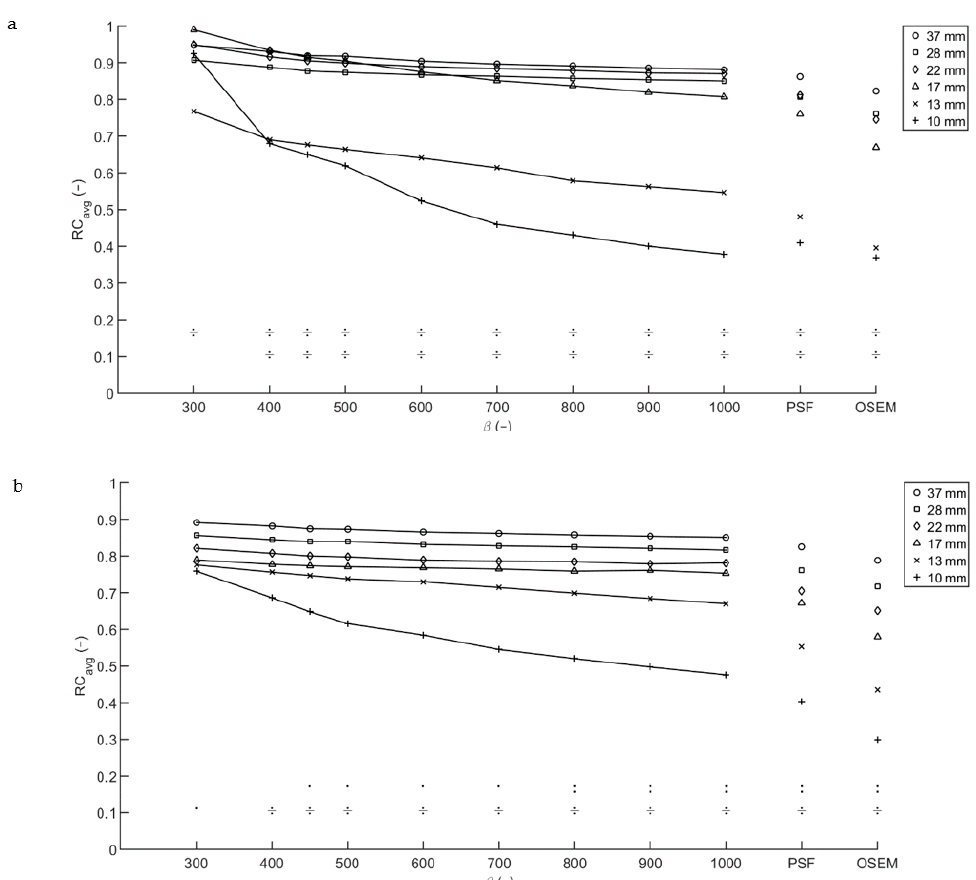
Figure 2. Recovery coefficients from the Image Quality phantom for multiple T/B ratios. RC avg for T/B ratio 10:1 ( a ) and 20:1 ( b ), with acquisition time per bed position of 2 min. The symbols in the lower part of both graphs denote the significance of the differences between the 13 mm sphere and the four biggest spheres (upper row) and the 10 mm sphere and the four biggest spheres (lower row). An obelus ( ÷ ) corresponds to p < 0.001, a colon to p < 0.01 and a single dot to p < 0.05.